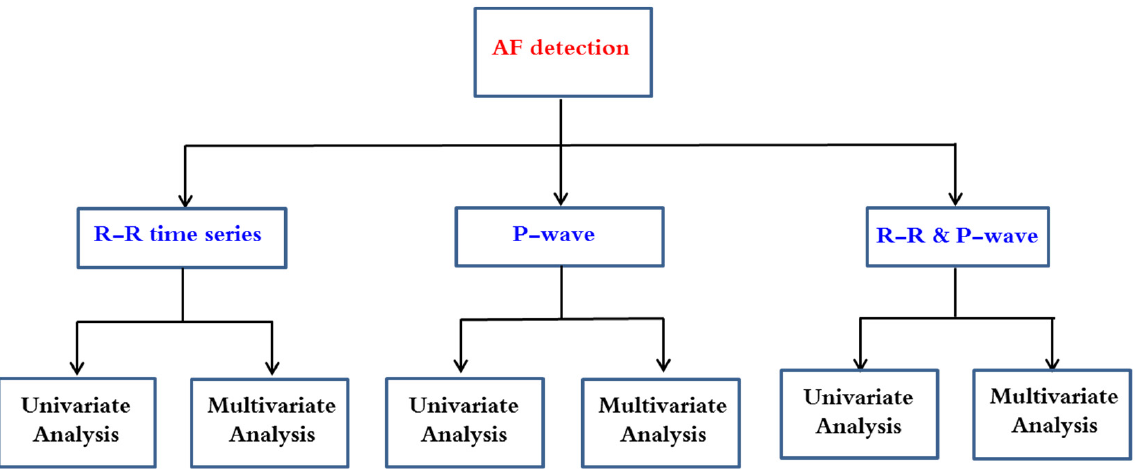
Figure 2. Automatic AF detection methodologies.